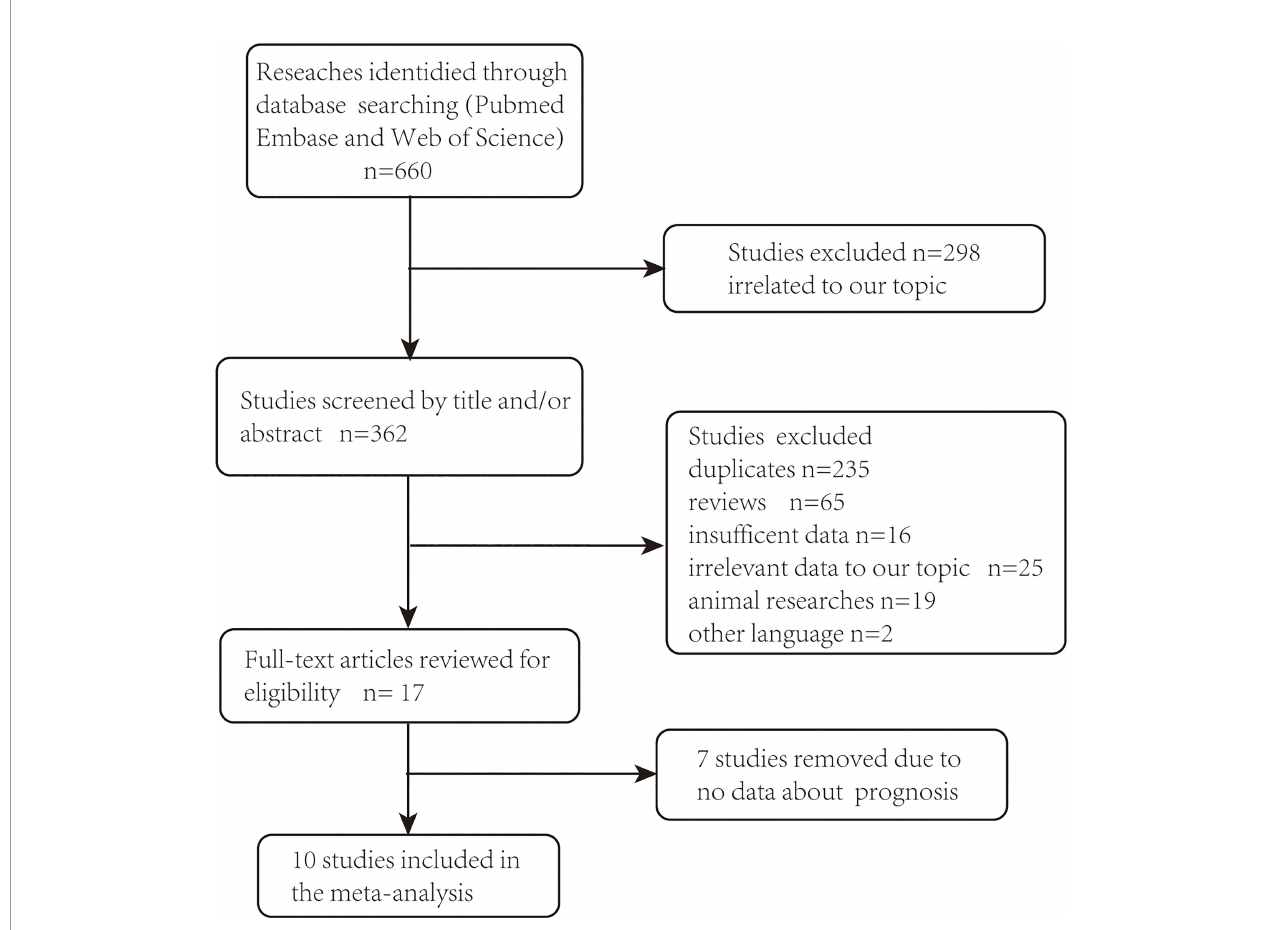
FIGURE 1 | PRISMA fl owchart of eligible studies selection